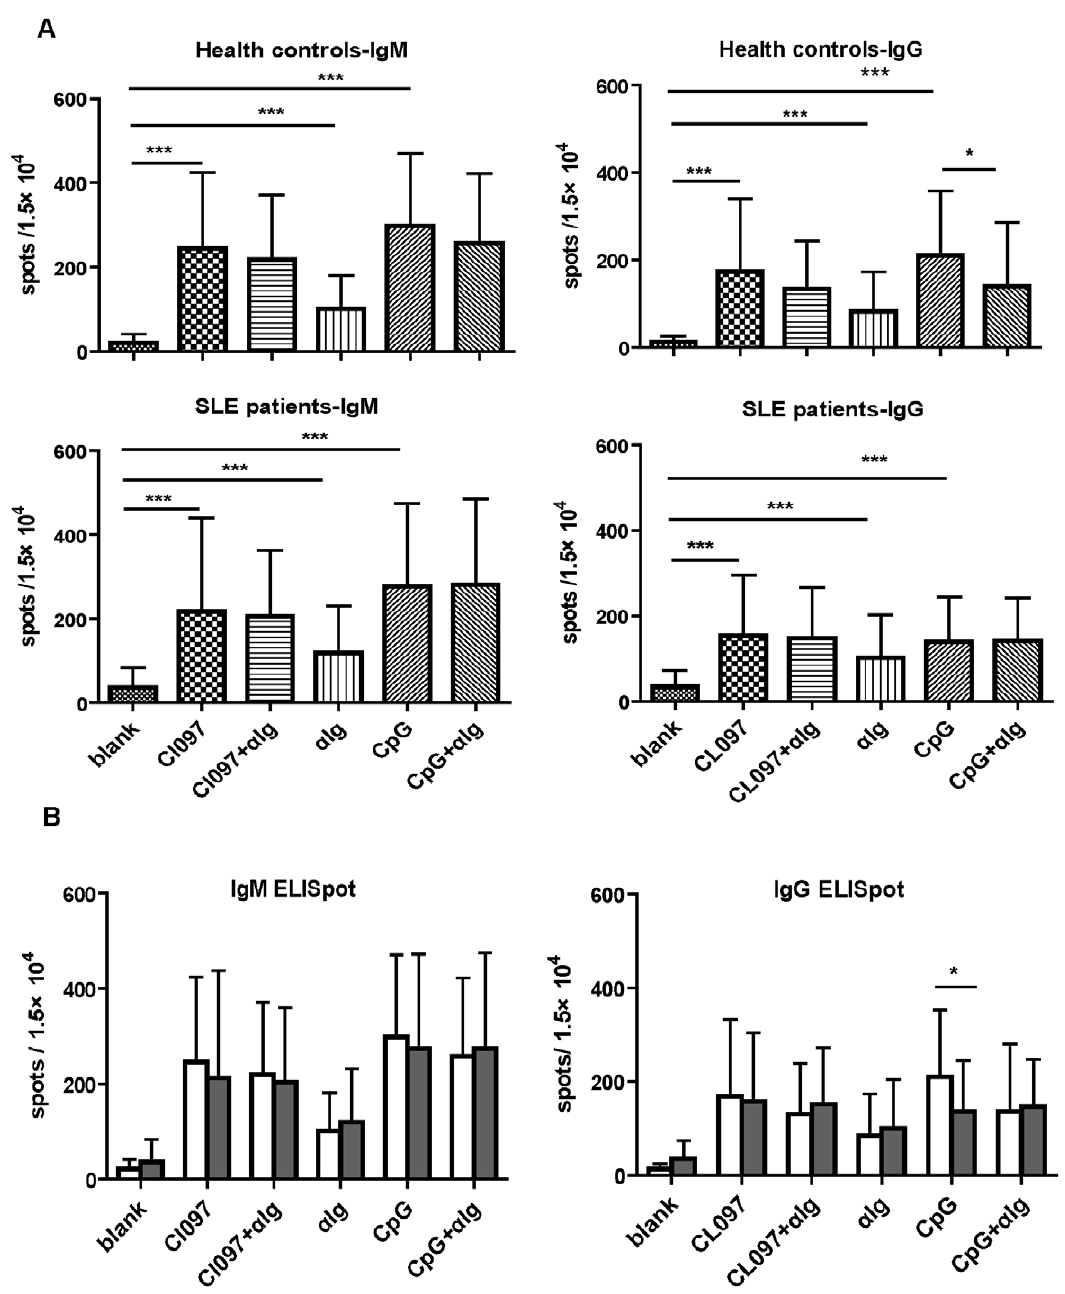
Figure 2. Frequency of antibody secreting cells among SLE B cells following TLR and/or BCR ligation. CD19 + B cells purified from SLE patients (n=17) and healthy controls (n=17) were cultured for 96 h in medium alone or in the presence of CL097 (2.5 m g/ml), CpGODN2006 (1 m M), anti-Ig(2.5 m g/ml), CL097 + anti-Ig, or CpGODN2006 + anti-Ig. The frequency of IgM- or IgG-secreting cells was analyzed by ELISPOT assay. A. The number of IgM- or IgG-secreting cells for each of 1.5 6 10 4 SLE or control B cells generated under the various conditions. B. Direct comparison of SLE B cells (filled bars) with control B cells (open bars) for their capacity to generate IgM- or IgG-secreting cells. Data are present as means 6 SD. Statistical significance was tested by non-paired t test. * P , 0.05, *** P , 0.0001.